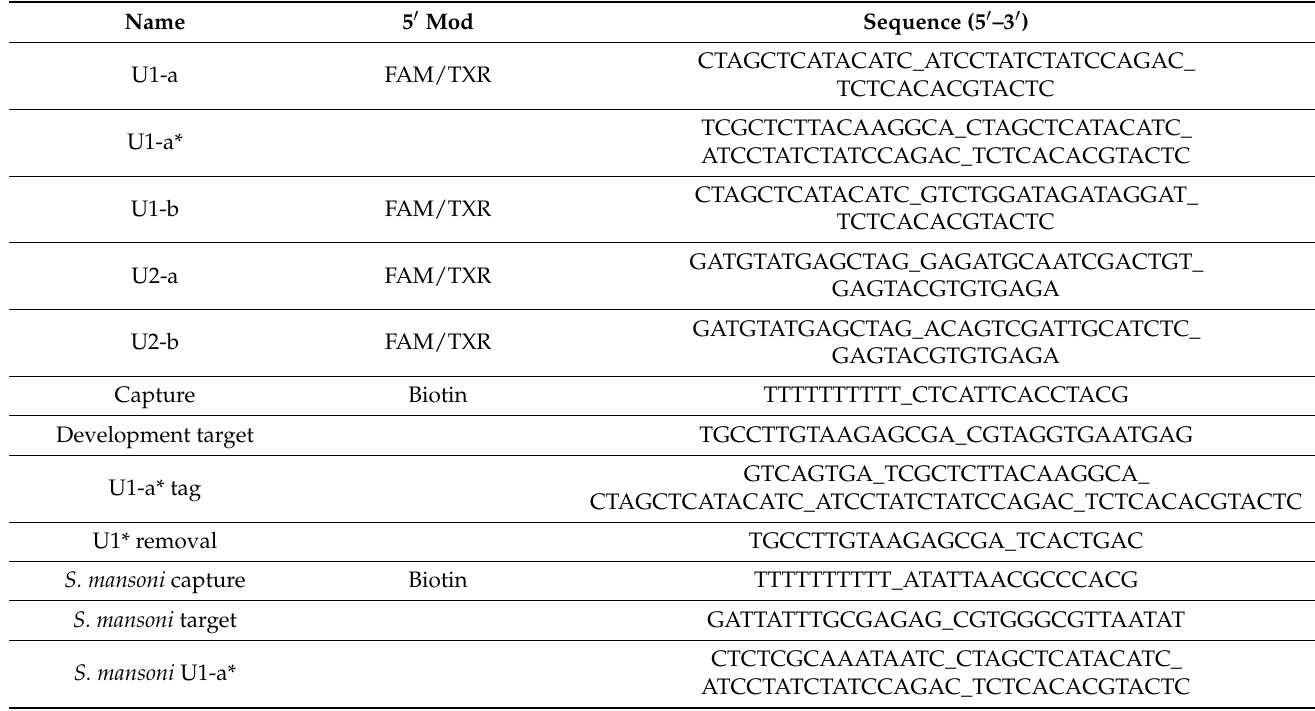
Table 1. Oligonucleotide sequences used in this